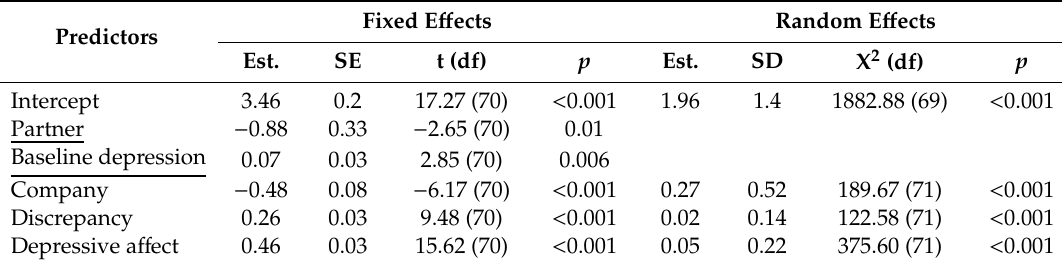
Table 2. Parameter estimates for multilevel model